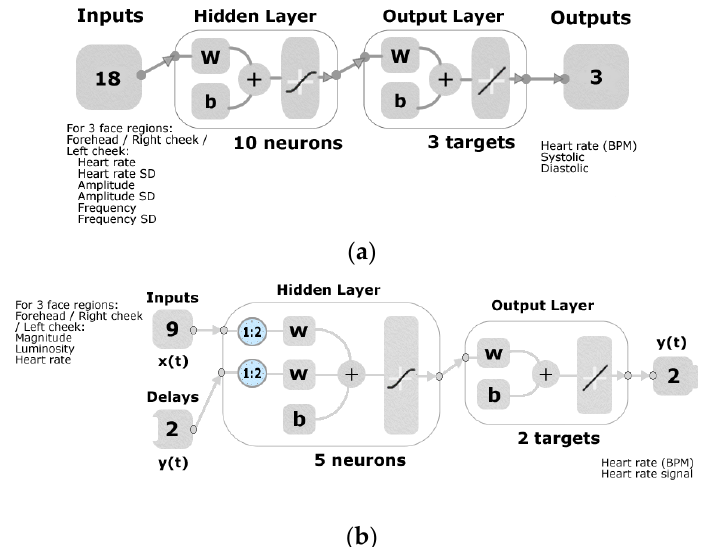
Figure 3. Diagrams of the machine learning models developed where: ( a ) shows Model 1 for regression fitting with a two-layer feedforward network and tan-sigmoid function in the hidden layer and a linear transfer function in the output layer, in which a total of 18 inputs and three targets/outputs used with ten hidden neurons, and ( b ) Model 2 using the shallow neural network time-series prediction with a series-parallel architecture using a tan-sigmoid function in the hidden layer and a linear transfer function in the output layer, nine inputs, two delays, two targets/outputs and five hidden neurons. Abbreviations: SD = standard deviation, w = weights and b = biases.